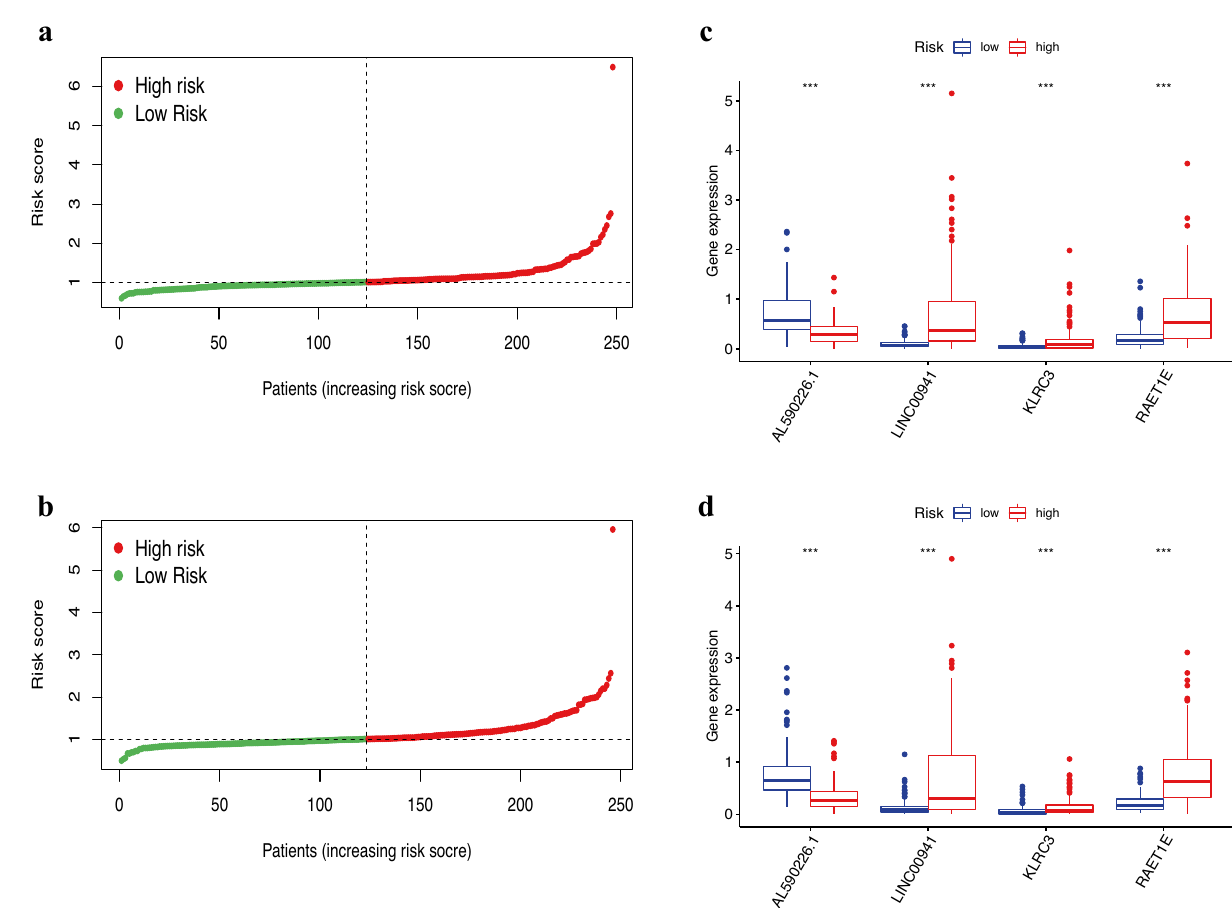
Figure 1. Model-based differentiation of distinct risk populations. ( a ) Distinct risk group division in the training set. ( b ) Distinct risk group division in the test set. ( c ) The expression of modeled mRNAs and lncRNAS in the two groups in the train set. ( d ) The expression of modeled mRNAs and lncRNAS in the two groups in the test